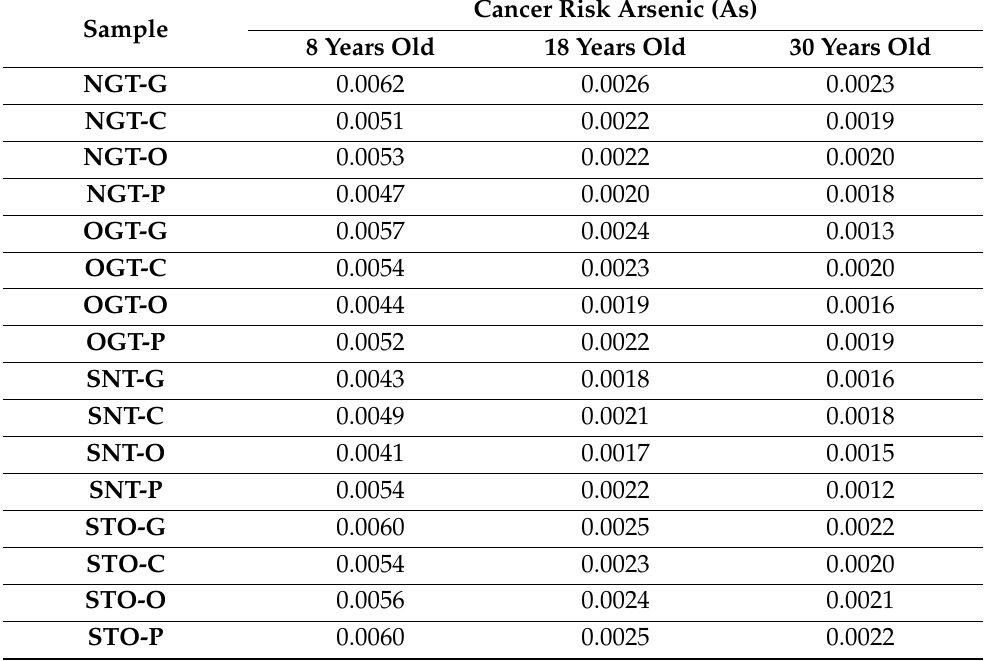
Table 2. Life exposure (Age = 8, 18, 30 years), values of carcinogenic risk (CR) due to exposure of As in canned NGT, OGT, SNT, and STO from the four companies (G, C, O, and P), considering a daily intake of 130 g/day.